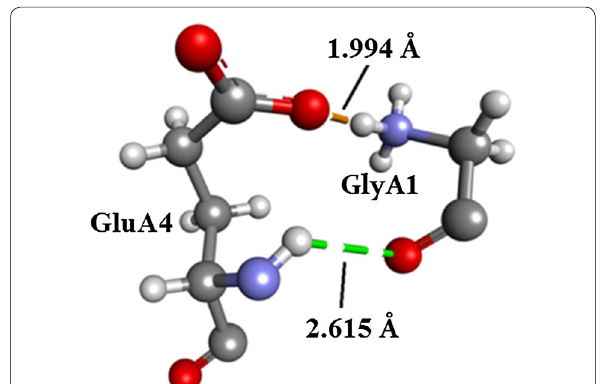
Fig. 9 The salt bridge GLYA1:HOC and GLUA4:OE1 in Insugen (I). Relevant distances in Å are indicated. Drawn with Biovia, Discovery Studio 2016 [35]